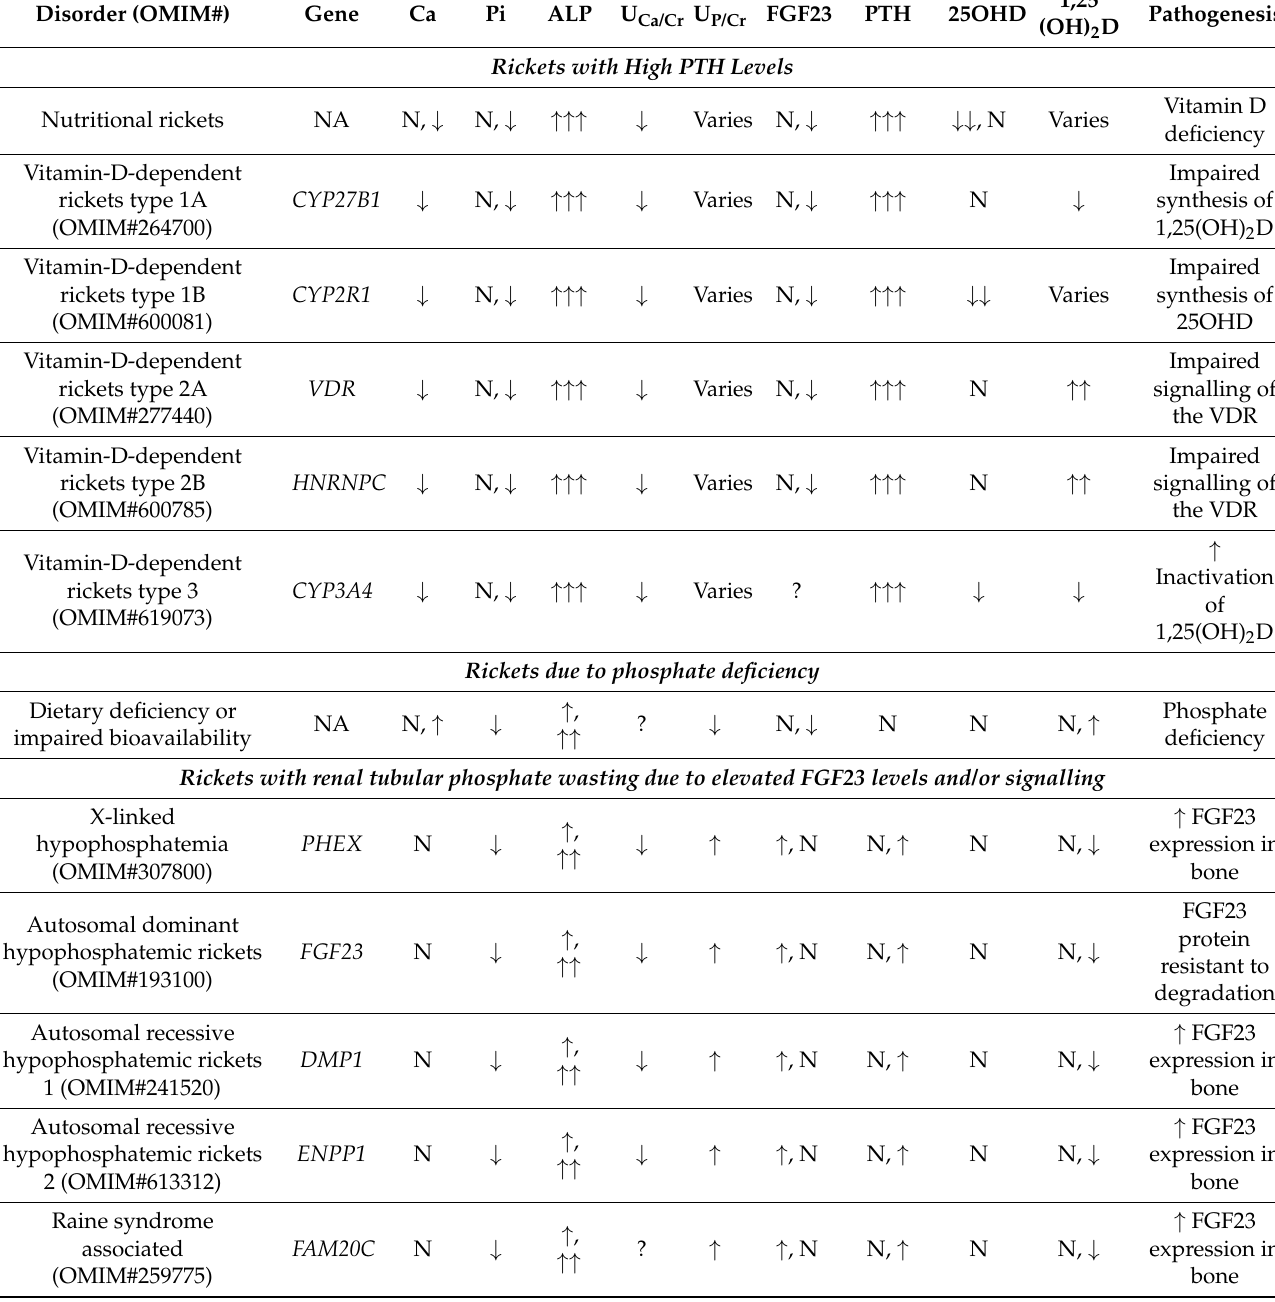
Table 7. Characteristics of inherited and acquired types of rickets. Adapted from Bitzan et al. [114], Haffner et al. [115], and Tiosano et al.